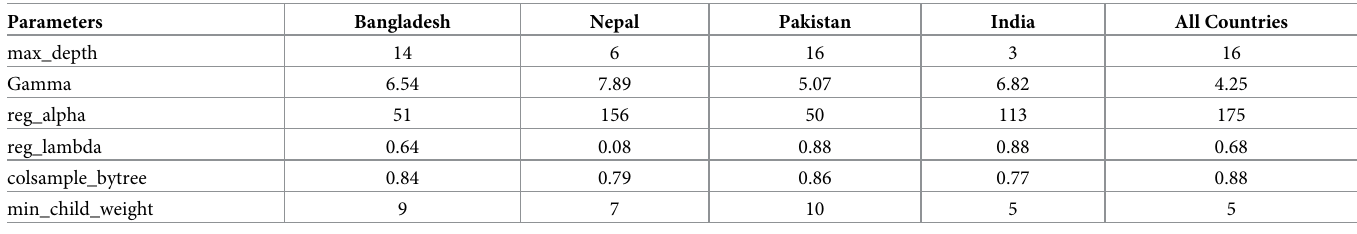
Table 4. Hyper-parameter